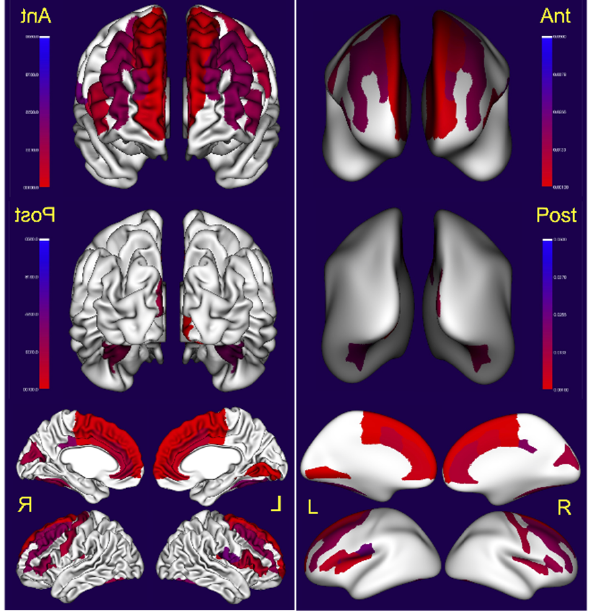
Figure 4. Visualization of the statistical significance of cortical thickness (left) measurements in cortical regions. On the right side, the inflated surface. Non-significant regions are in white, significant regions (following correction for multiple comparison) are shown in blue ( p < 0.05) to red ( p < 0.001). Significant changes in surface areas were also documented (Figure 5).